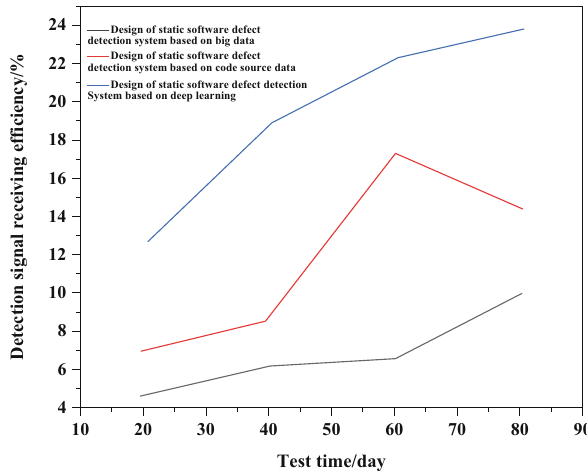
Figure 6: Comparison of detection signal receiving e ffi ciency.